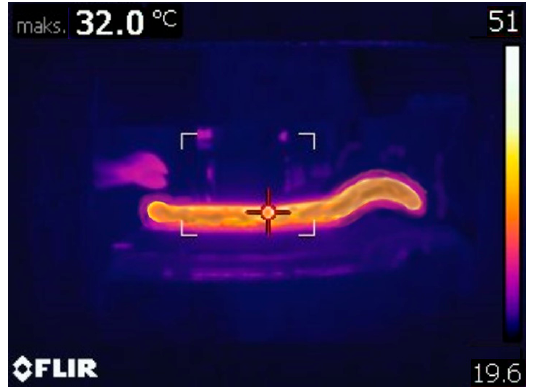
Figure 3. Thermovision analysis of the clay band and tool set .